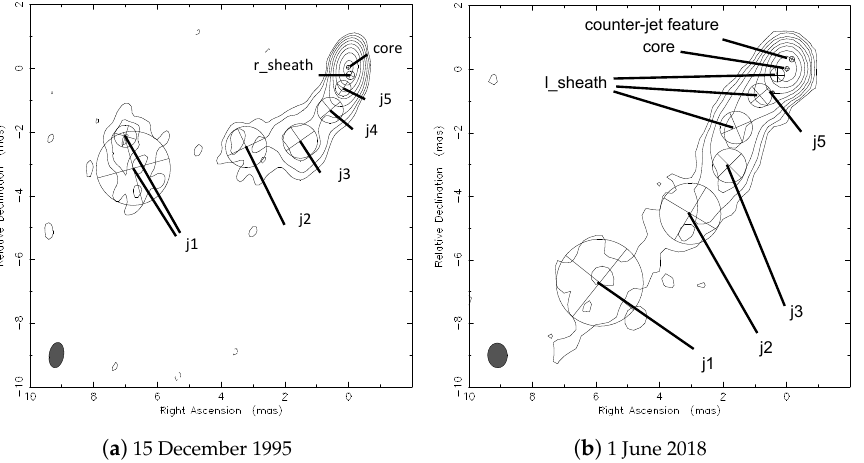
Figure 1. The jet mapped with the VLBA at 15 GHz at two different epochs. ( a ) The pc-scale structure observed on 15 December 1995 and ( b ) as observed on 1 June 2018. In both maps, we have labeled the model-fit Gaussian components. Note that not every jet component is identifiable in each observation. While the jet appears strongly curved in ( a ), it appears essentially straight in ( b